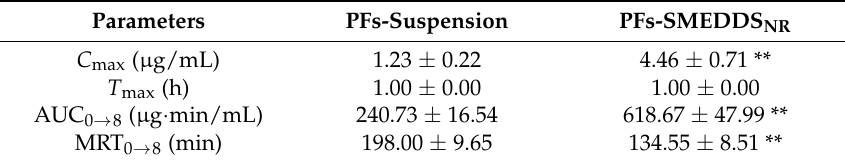
Table 1. Pharmacokinetic parameters of oral administration in saline-pretreated rats at a dose